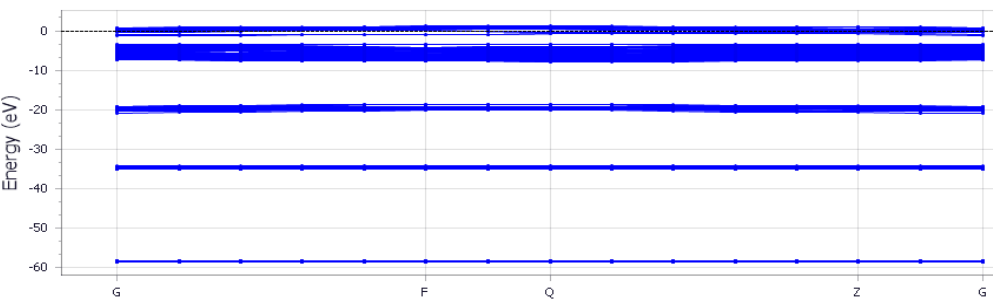
Figure 2. Energy band structure of Ti 3 O 5 crystal.